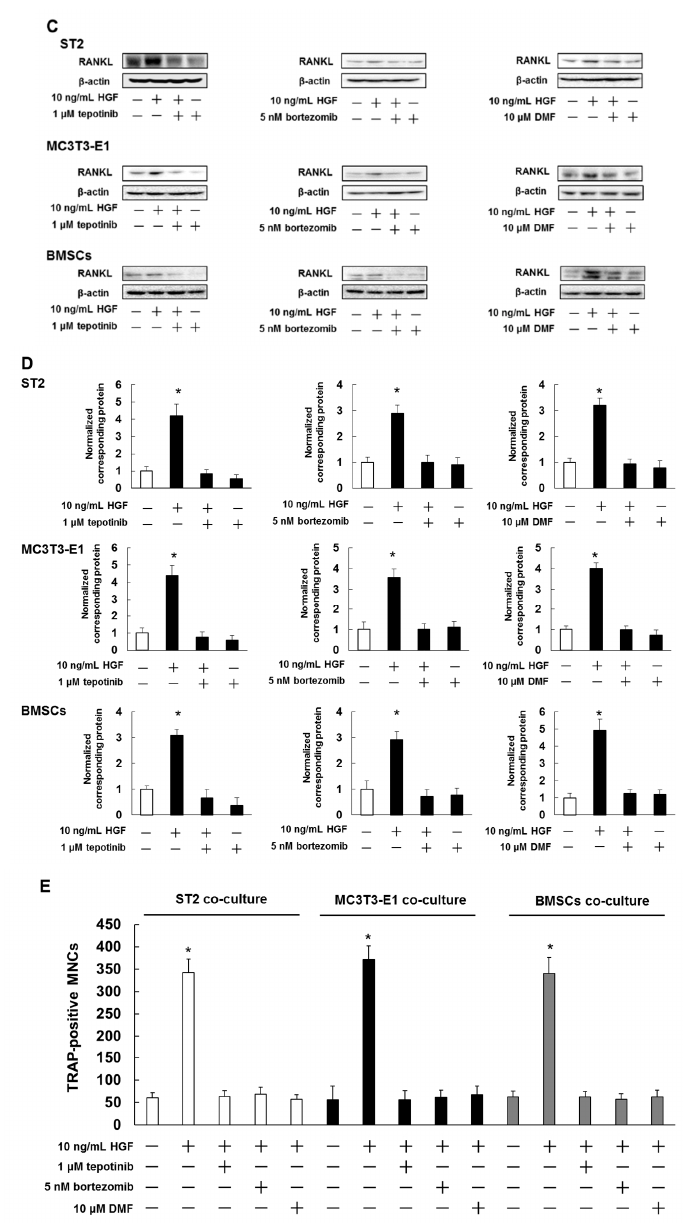
Figure 5. Met and NF- κ B inhibitors suppress HGF-induced RANKL expression. ( A ) ST2 cells, MC3T3-E1 cells, and mouse BMSCs were incubated in 96-well plates for 24 h and then treated with various concentrations of tepotinib, bortezomib, or DMF. After 5 days, cell viability was quantified by the trypan blue dye assays. The results are representative of five independent experiments. * p < 0.01 vs. the controls (one-way ANOVA with Dunnet’s test). ( B – D ) ST2 cells, MC3T3-E1 cells, and mouse BMSCs were treated with 1 µ M tepotinib, 5 nM bortezomib, or 10 µ M DMF. After incubation for 72 h, HGF was added to give the final concentration of 10 ng / mL. ( B ) After incubation for 4 h, RNA was extracted, and RANKL mRNA expression was analyzed by real time PCR. The results are representative of five independent experiments. * p < 0.01, as compared to controls (one-way ANOVA with Dunnett’s test). ( C ) After incubation for 72 h, the cell lysates were analyzed by western blotting using anti-RANKL antibody. ( D ) Quantification of the amount of RANKL, normalized to the amounts of β -actin. The results are representative of five independent experiments. * p < 0.01, compared to controls (one-way ANOVA with Dunnett’s test). ( E ) After culturing ST2 cells, MC3T3-E1 cells, and mouse BMSCs, the cells were individually co-cultured with RAW264.7 cells and tartrate-resistant acid phosphatase (TRAP)-positive multinucleated cells (three or more nuclei), and were subsequently counted under a microscope after 7 days. The results of five independent experiments are presented